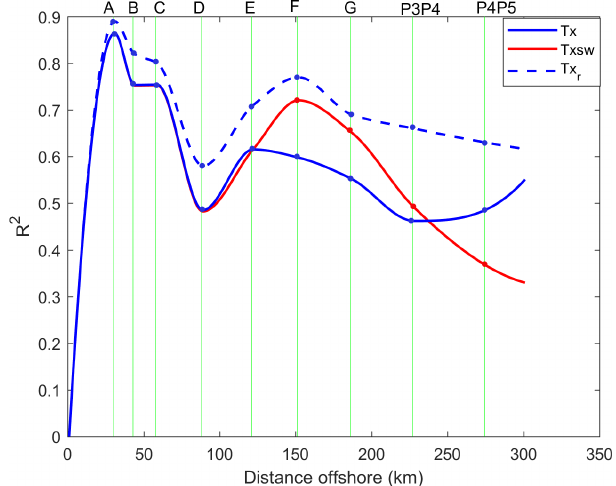
Figure 4. R 2 statistics from the linear regression models showing the relationship between HYCOM SSH slope and HYCOM trans- port per unit distance for each mooring (A–G) and CPIES pair (P3P4 and P4P5) over the 3-year reference period (2010–2013). Tx is represented by the solid blue line and Txsw by the solid red line. The dashed blue line represents the results of Tx after the removal of the residual transport events (see Sect. 3.4). Sites A to CPIES pair P4P5 are shown by the faint green lines.